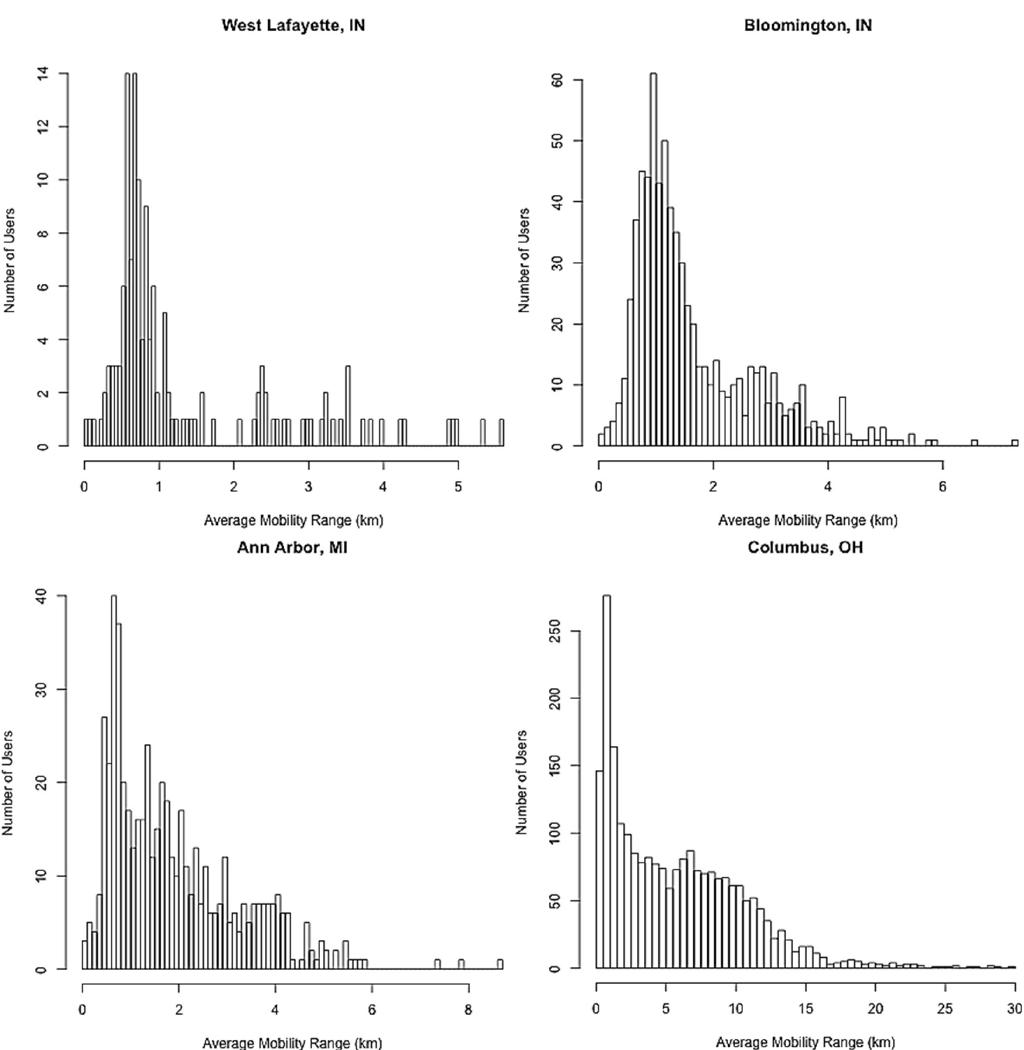
Figure 8. Distribution of average mobility ranges of frequent users.